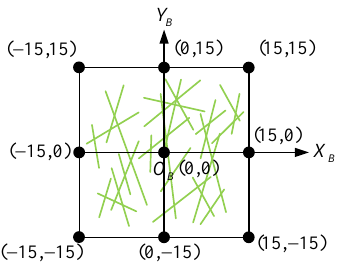
Figure 4. BRIEF template and its coordinate system.